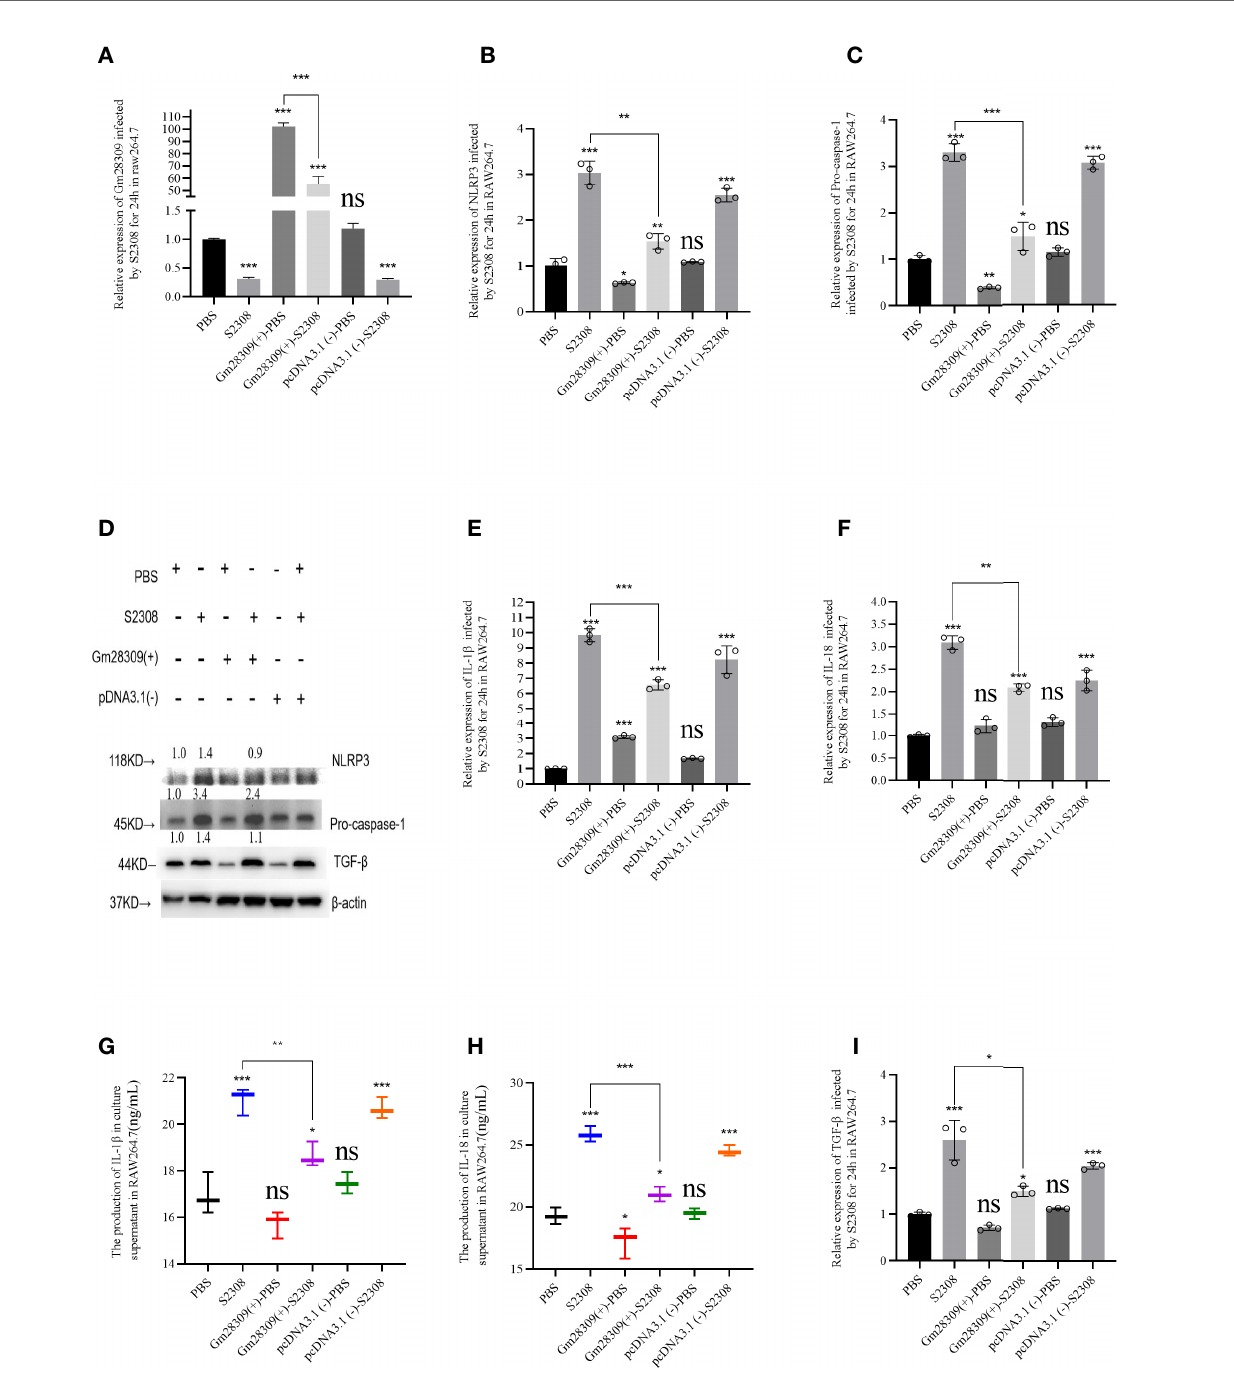
FIGURE 4 | Gm28309 overexpression negatively regulates the production of NLRP3 in fl ammasome in RAW 264.7 cells infected by S2308. (A) Expression of Gm28309 in RAW264.7 cells transfected with the overexpressed plasmid Gm28309-pcDNA3.1, as detected using qRT-PCR. (B , C , E , F , I) . The relative expression of NLRP3, Pro-caspase-1, IL-1 b , IL-18, and TGF- b when overexpressed Gm28309 in RAW264.7 cells, as detected using qRT-PCR. (D) expression of NLRP3, Pro- caspase-1, and TGF- b as detected using western blotting when overexpressed Gm28309 in RAW264.7 cells. (G , H) IL-1 b and IL-18 levels in the supernatants in RAW264.7 cells transfected with the overexpressed plasmid Gm28309-pcDNA3.1 as detected usjing ELISA. Data shown are mean ± SD (n = 3). *p < 0.05, **p < 0.01,***p < 0.001, one-tailed t-test. ns, not signi fi